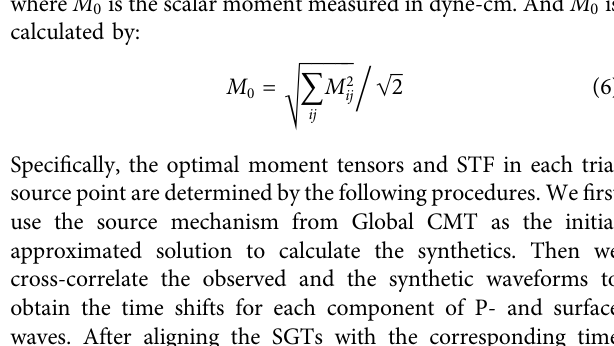
Frontiers in Earth Science |